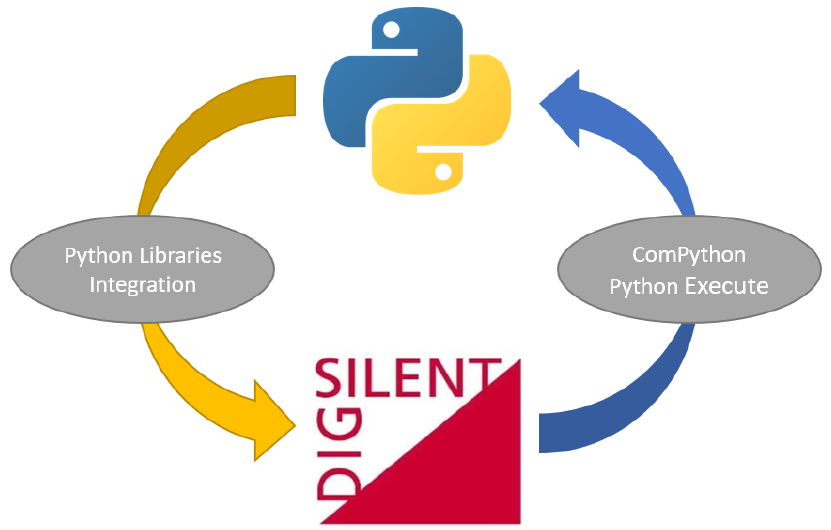
Figure 3. DIgSILENT Power Factory and Python Programming Language